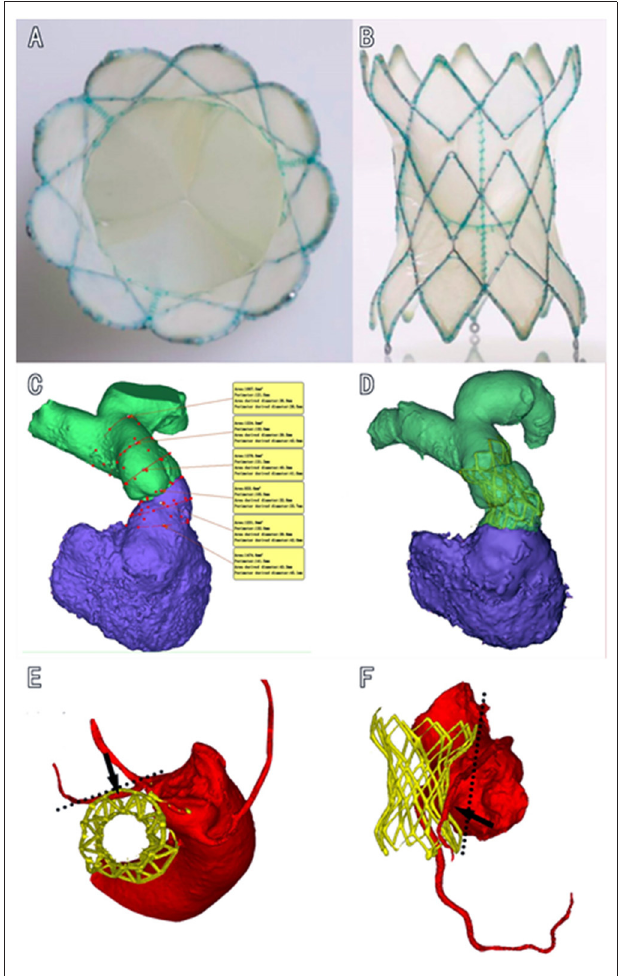
FIGURE 1 | Diagram of the dumbbell-shaped Med-Zenith PT-Valve. (A) : Cross section view of PT-Valve. (B) : Longitudinal view of PT-Valve; (C) : Multi-level measurements based on 3D reconstruction of RVOT and MPA. (D) : Valve was implanted into the desired position conformed by post-operational CTA, showing that the dumbbell-shape design of PT-Valve provides sufficient contact surface in the dilated pulmonary artery and RVOT without compression of the valve (waist of the frame remains uncompressed), while the tension force of the device lays on the double ends of the frame. (E,F) : Left anterior descending artery is away from the out layer of the stent in the cross-sectional and longitudinal views, respectively. RVOT, right ventricular out flow tract; MPA, main pulmonary artery; CTA, computed tomography